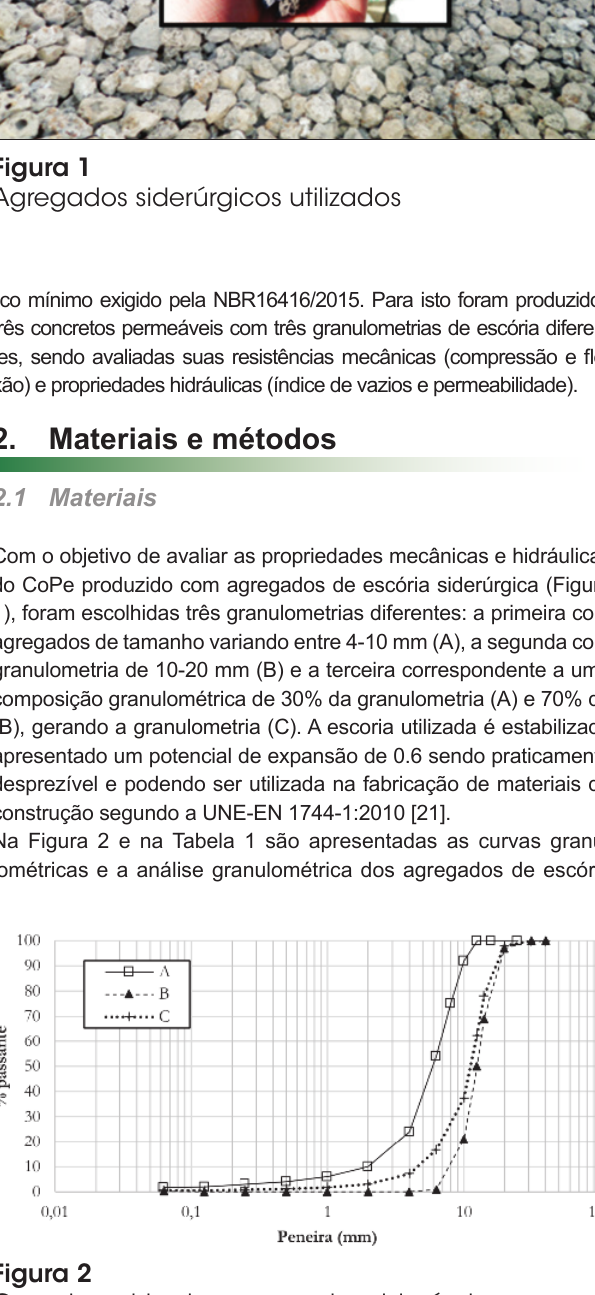
Granulometria dos agregados